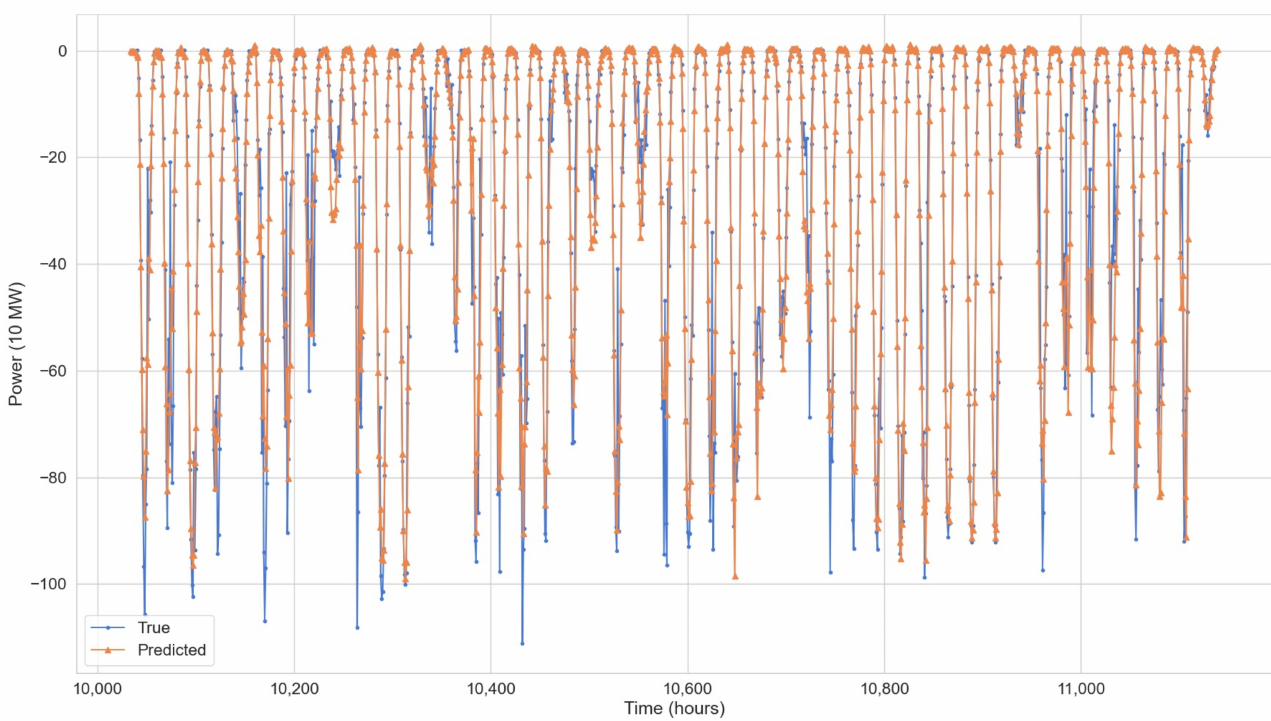
Figure 10. True PV capacity vs. Predicted PV